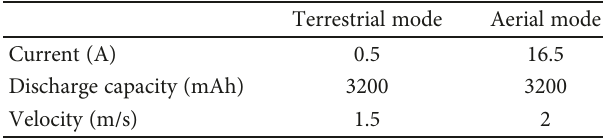
Figure 14: Calculated the output torque tendencies of a single servo. Table 2: Experimental data in aerial and terrestrial modes.